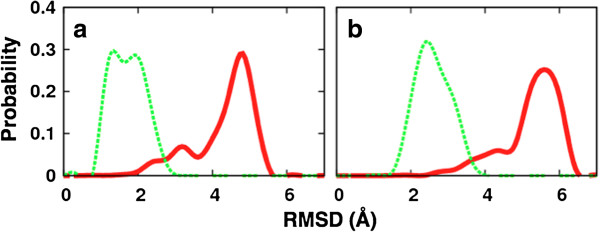
Distributions of the root-mean-square deviation of MD snapshots from the reference X-ray structure (PDB ID: 2V1D). Red: unbound MD ensemble. Green: H3-bound MD ensemble. Either (a) backbone or (b) all-heavy atoms of the residues lining the H3-binding site were considered for least-square fitting and RMSD calculation.